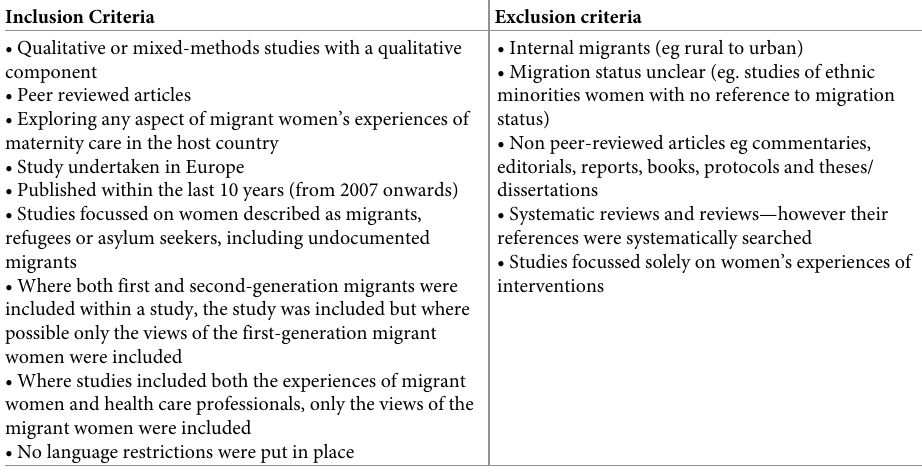
Table 1. Inclusion and exclusion